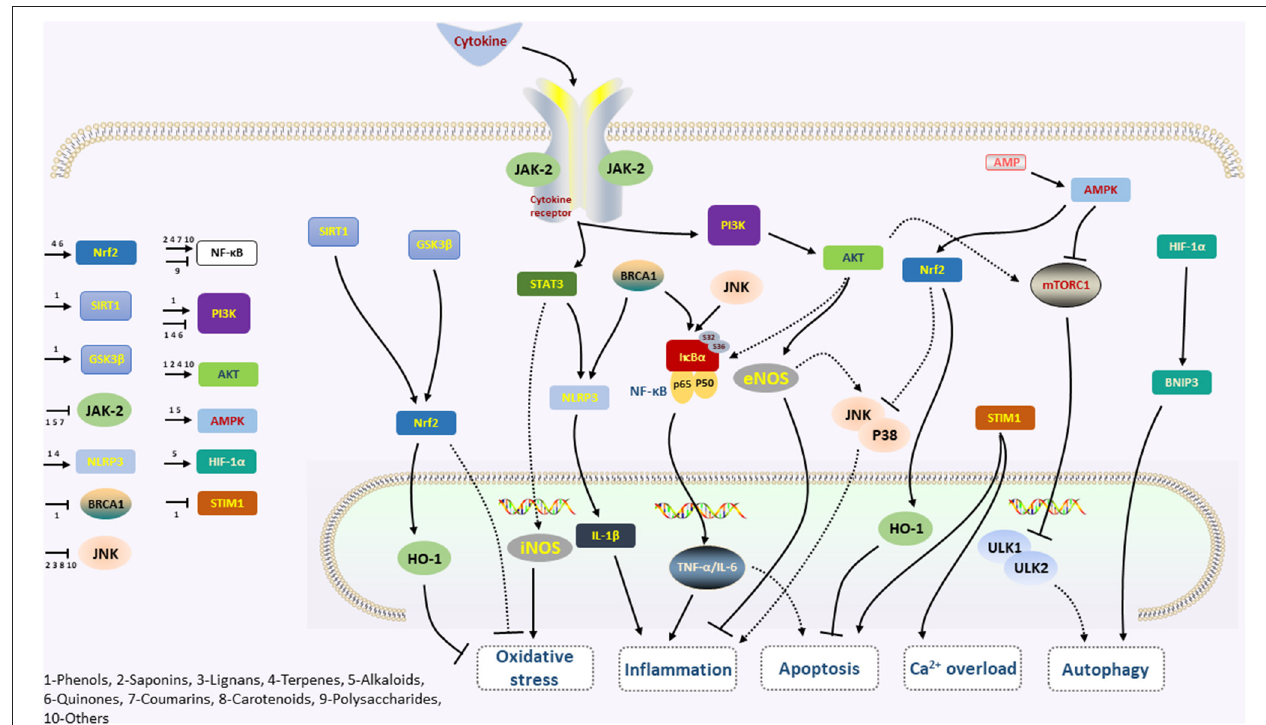
FIGURE 2 | The simplified mechanism scheme of phytochemicals in cardiovascular disease. Phytochemicals reduce the phosphorylation of STAT3 by inhibiting JAK2, which is activated following the binding of cytokines and cognate receptors. Inhibition of the JAK/STAT pathway leads to decreasing of iNOS and NLRP3/IL-1 β levels, and thus protects against oxidative stress and inflammation. Activation of the AMPK signaling pathway may also play a key role in the anti-inflammation, further acting on the mTOR and Nrf2 factors and participating in the actions of phytochemicals on oxidative stress, apoptosis, and autophagy. Moreover, the NF- κ B signaling pathway, activated by the BRCA1, JNK, and AKT, promotes the expression of TNF- α and IL-6, which regulate inflammation and apoptosis. The phytochemicals are also against apoptosis and inhibit Ca2 + accumulation via the STIM1 pathway. The PI3K-AKT signaling pathway is activated by many types of cellular stimuli or toxic insults, activates downstream mTOR, eNOS, and NF- κ B, and sequentially regulates the inflammation and